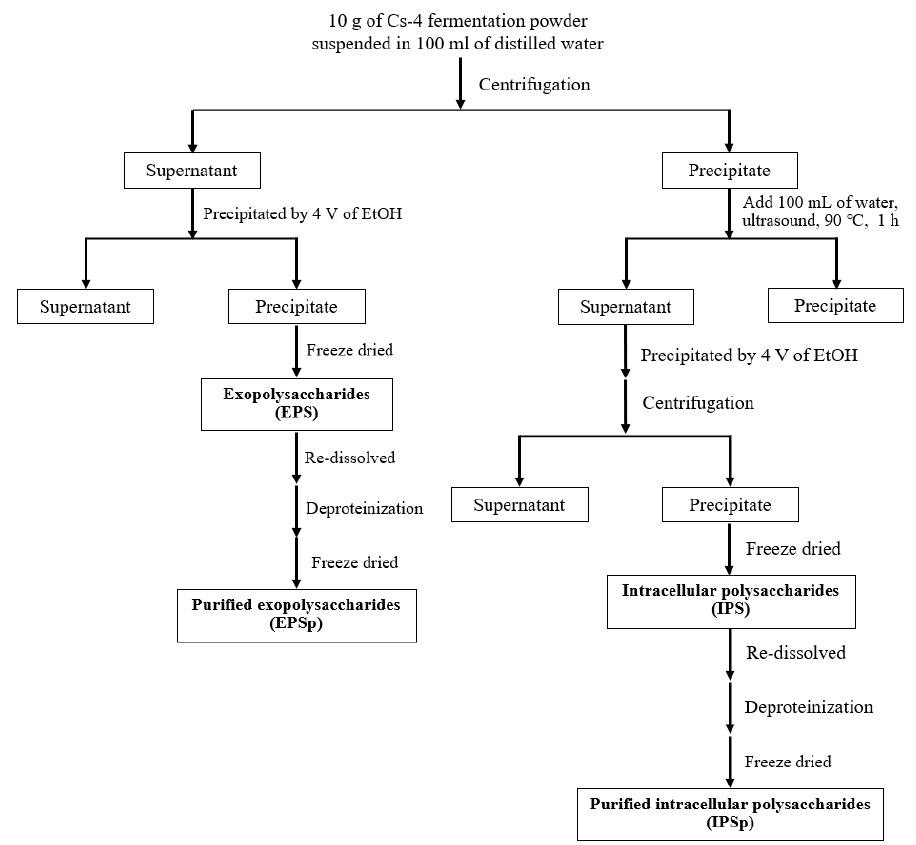
Figure 7. Production process of Cs-4